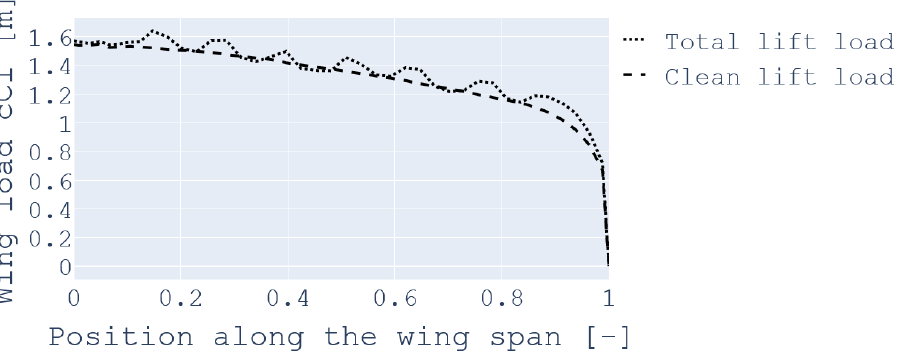
Figure 5. Lift load distribution along the dimensionless wing